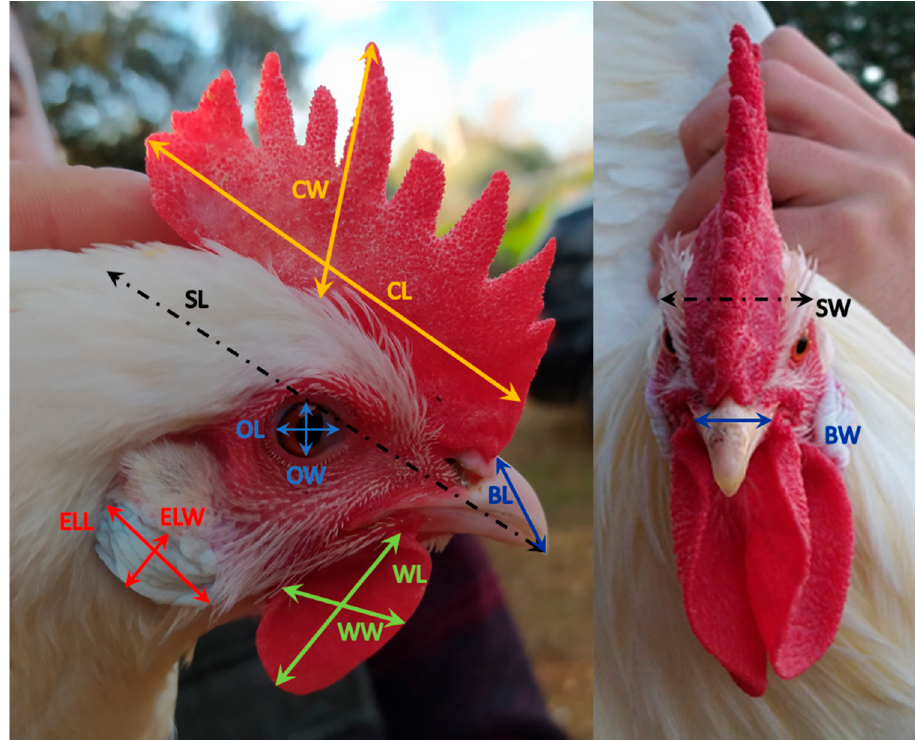
Figure 2. Detailed views of a hen and a rooster head with their corresponding measures. CL: comb length, CW: comb width, OL: ocular length: OW: ocular width, SL: skull length, SW: skull width, BL: beak length, BW: beak width, ELL: earlobe length, ELW: earlobe width, WL: wattle length, WW: wattle width.